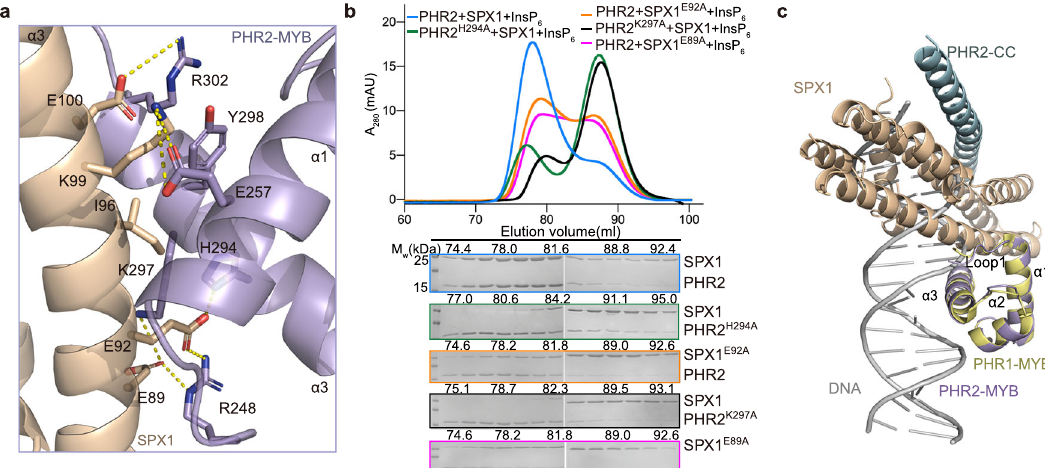
Fig. 5 Structural basis for PHR2 DNA binding inhibition by SPX1. a Close-up view of SPX1-PHR2 MYB interface. Critical interface residues were shown as sticks and labeled. The yellow dashed lines represent hydrogen bonds. b Mutations disrupted the SPX1 1 – 198 -PHR2 248 – 380 complex formation. (Upper) Gel fi ltration pro fi les of SPX1 1 – 198 mutants and PHR2 248 – 380 mutants were color-coded. (Lower) Coomassie-blue stained SDS-PAGE gels of peak fractions. Experiments were independently repeated three times with similar results. Uncropped gel images are available as source data. c SPX1 occupied the PHR2 MYB-DNA binding region. Helix α 3 and loop 1 of MYB involve in DNA binding and SPX1 interacting based on superimposition of SPX1-PHR2 complex and AtPHR1 MYB-DNA complex (PDB:6J4R).